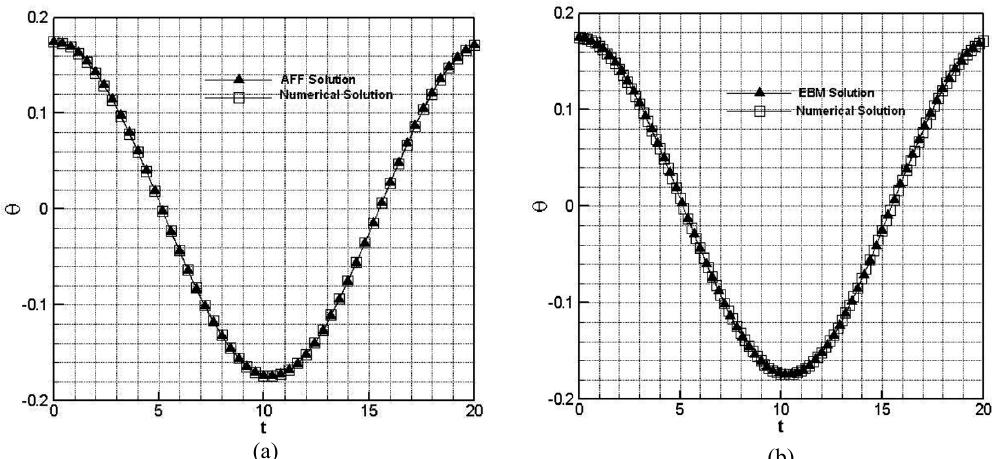
Fig. 3. Comparison of AFF and EBM solution with numerical results for θ ( t ) (case 1).